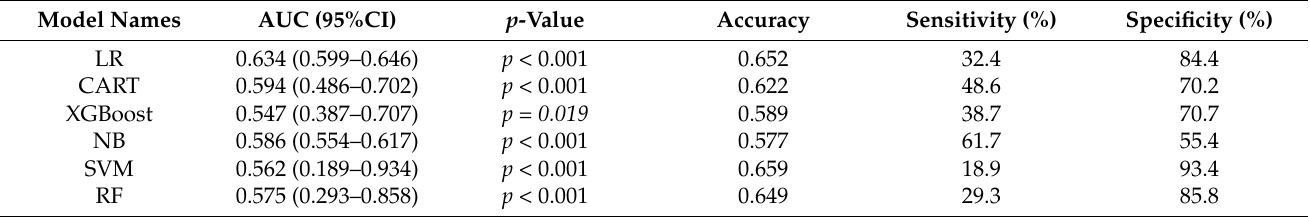
Table 1. The six-month HF re-admission prediction results of the 6 machine learning